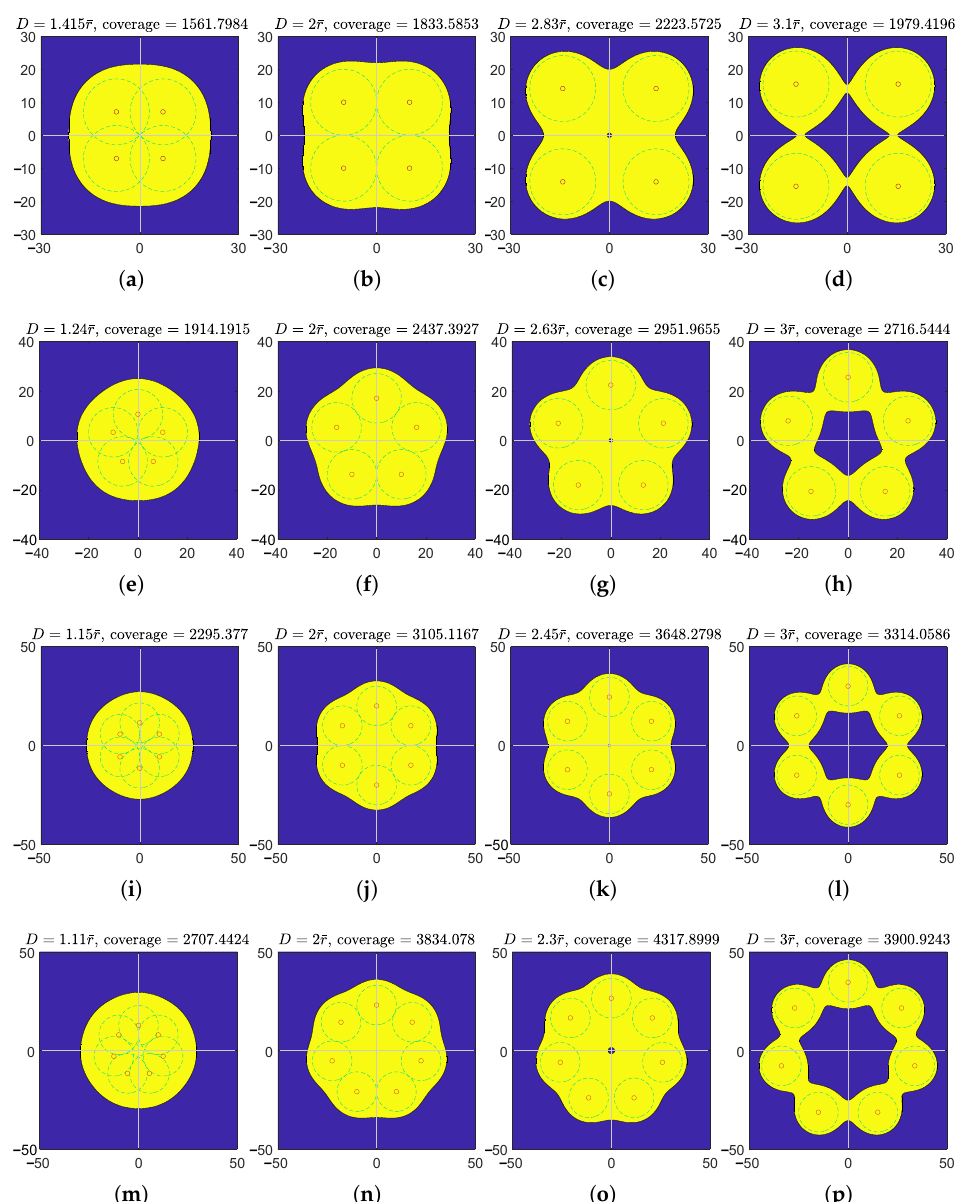
Figure 9. Illustration of effective coverages of n -node teams equipped with model I ( d ) = β / d 2 where n = 4,5,6, 7. The teams are in regular polygon formations. ¯ r = 10. Each row represents an n value. In the first column ( a , e , i , m ), individual effective coverage disks of every other node (i.e., i and i + 2) on the polygon vertices are tangent. In the second column ( b , f , j , n ), the individual effective coverage disks of every adjacent node pair are tangent. The third column ( c , g , k , o ) is the “max column”, where teams’ effective coverages are maximized. Each effectively covered region in the fourth column ( d , h , l , p ) has an effective coverage hole inside, while the region is still